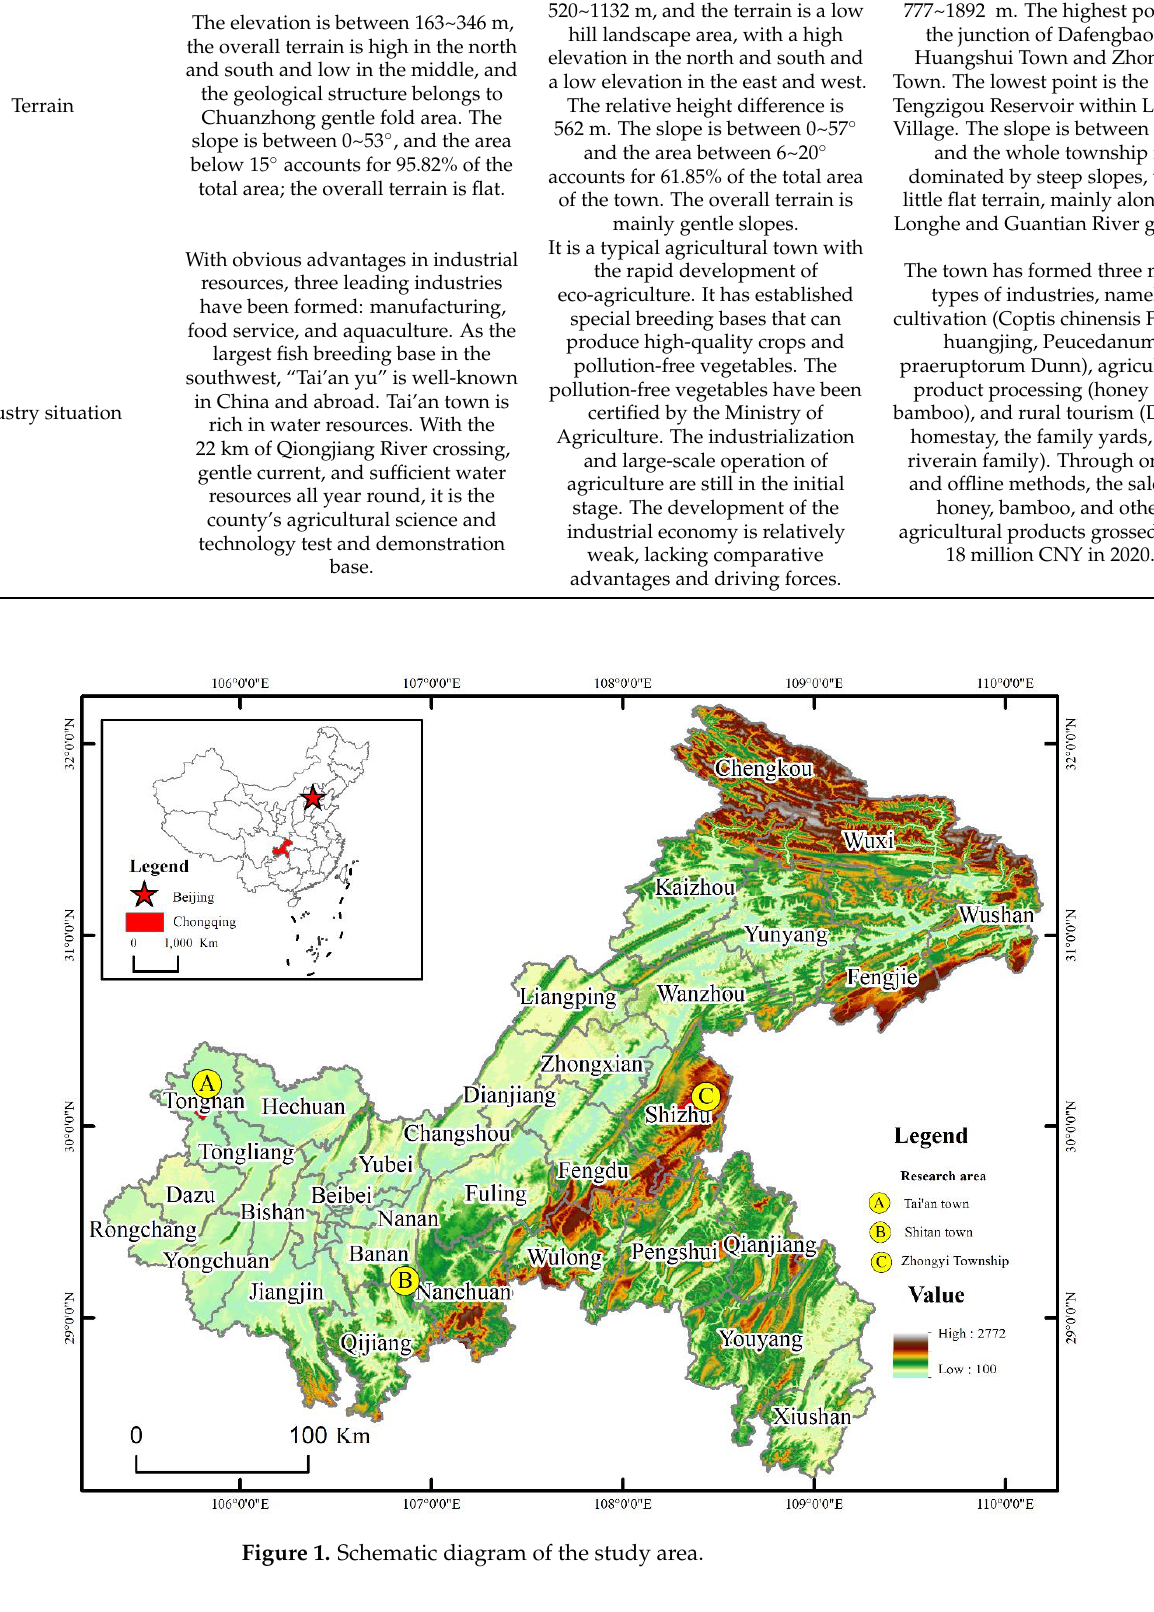
Figure 1. Schematic diagram of the study area. Table 1. Basic information for the selected towns.